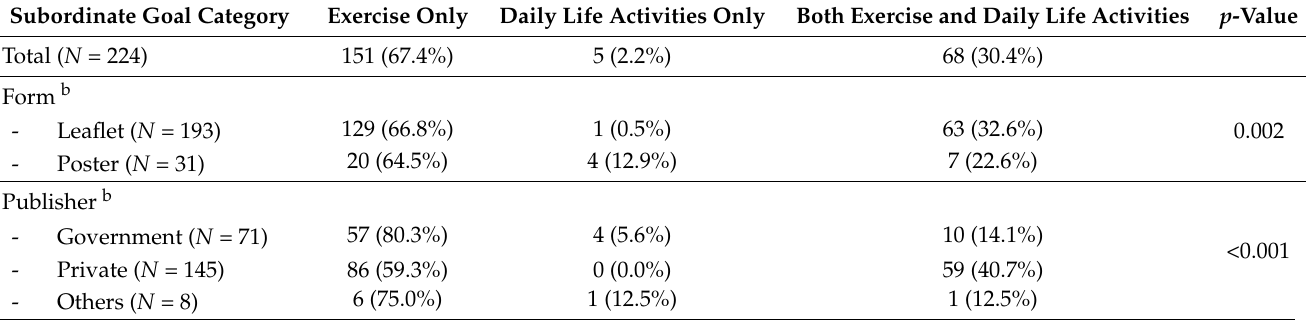
Table 4. Categories of Subordinate Goals in the PA Print Materials ( N =